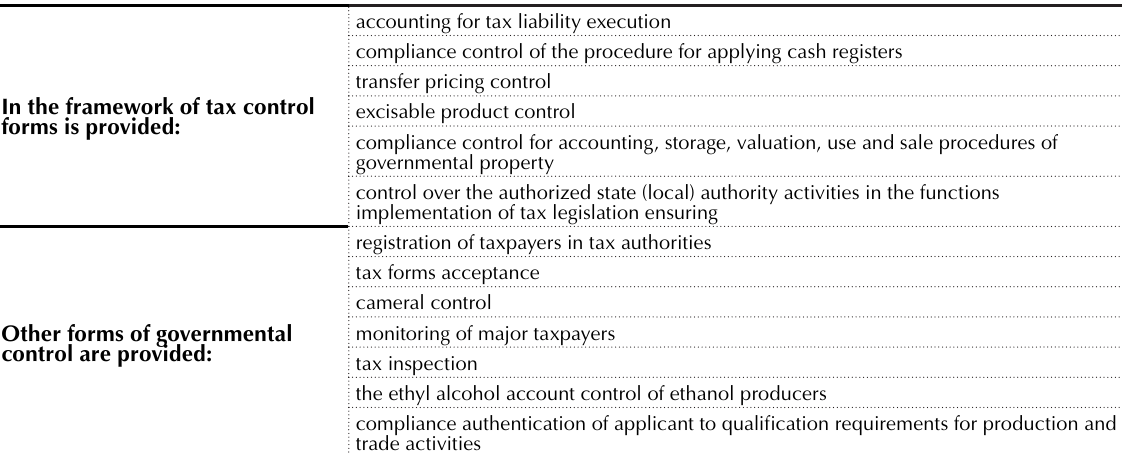
Table 1. Forms of tax control exercising their functions Source: Compiled by the author according to the legislation of the Republic of Kazakhstan.